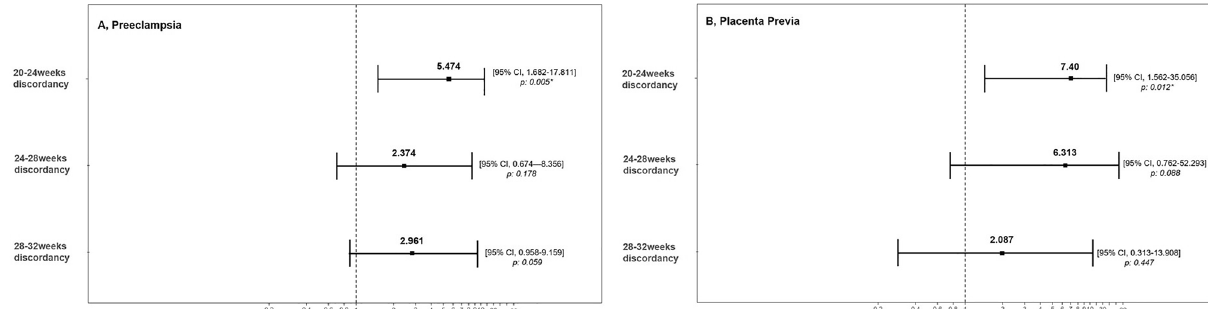
Figure 1. Regression analysis of the relationship between twin discordancy and risk of maternal obstetric complications after adjustment for the confounding factors of maternal age, pre-pregnancy BMI, BMI at delivery, and gestational age at delivery. ( A ) Preeclampsia, ( B ) Placenta previa. Odds ratios (ORs) and 95% confidence intervals (CIs) were calculated, and a p value of < 0.05 was considered to be statistically significant. BMI, body mass index.